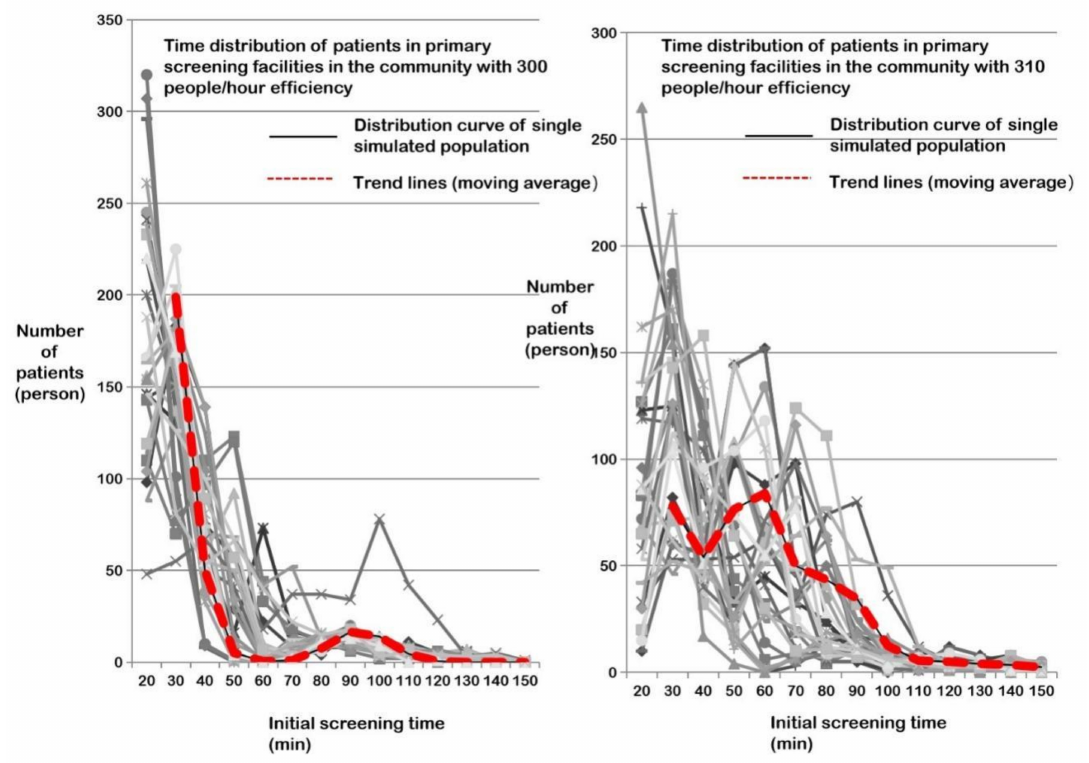
Figure 7. Statistical chart of residents’ time distribution in community primary testing at the efficiency of 300–310 persons/h (30 times for each